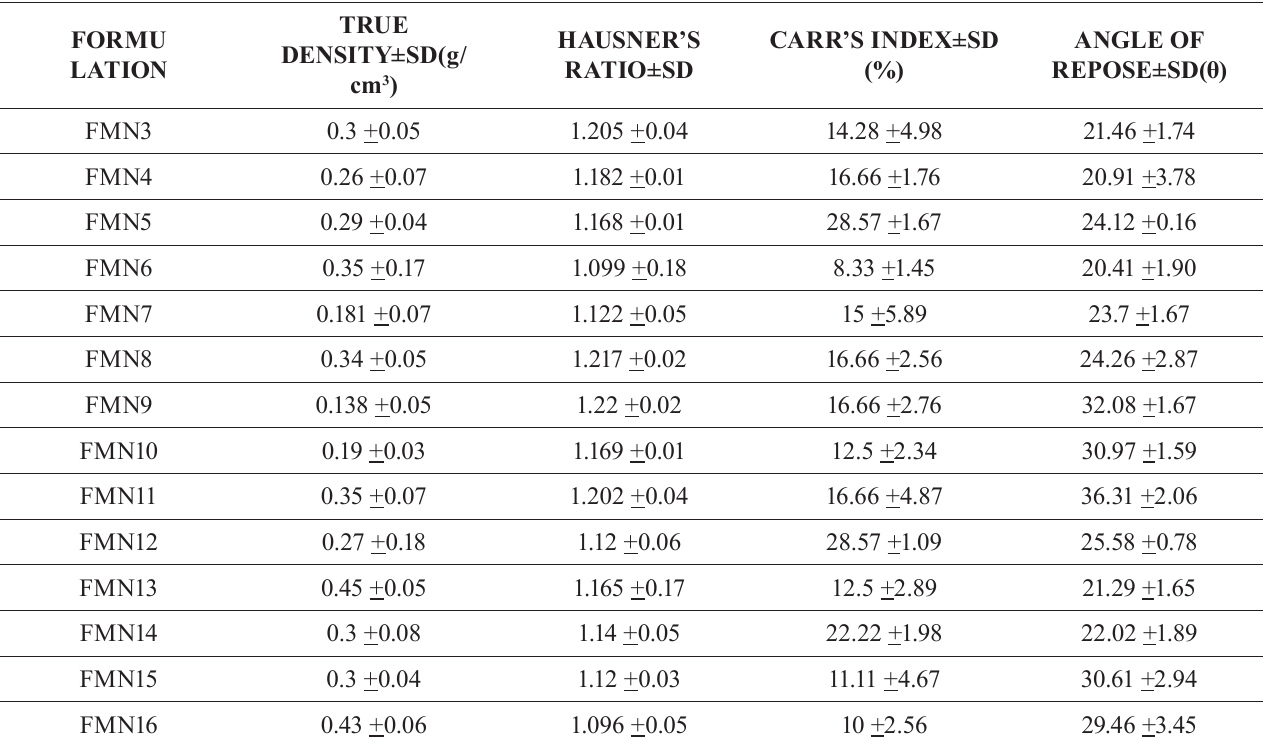
TABLE III - Results of true density, Hausner’s ratio, Carr’s index and angle of